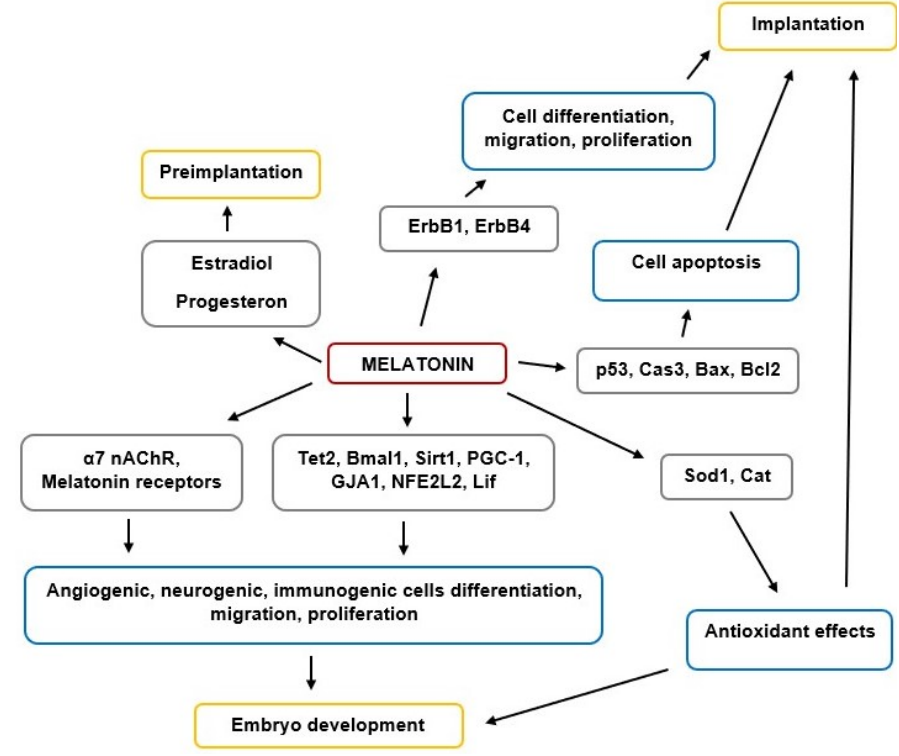
Figure 1. The scheme of MT’s effects on implantation and embryogenesis. MT acts at many levels over the course of embryogenesis, including the preparation of the organism for pregnancy (follicle maturation, ensuring endometrium receptivity) and subsequent embryo development at various stages. MT effects include antioxidant, anti- inflammatory and mitochondria-optimizing effects, with pineal MT proposed to induce the mitochondrial melatonergic pathway, thereby optimizing mitochondrial function, sirtuin induction and endogenous antioxidant